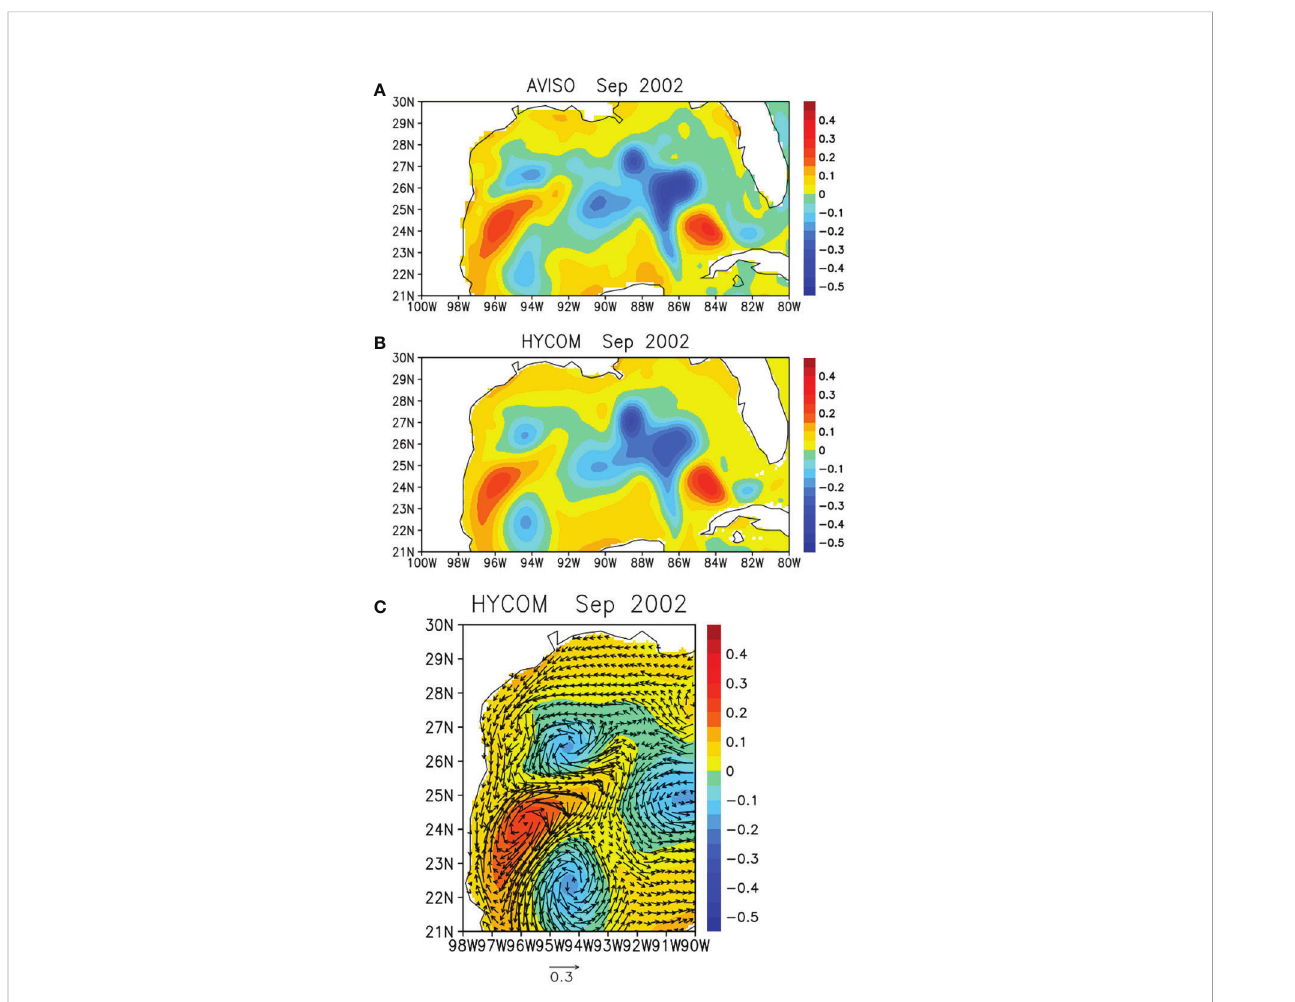
FIGURE 5 (A) Monthly mean SSH anomalies in the Gulf of Mexico in September 2022 derived from AVISO. (B) Same as (A) except for SSH anomalies from the HYCOM reanalysis. (C) SSH (shading) and surface currents (arrows) anomalies in September 2022 derived from the HYCOM